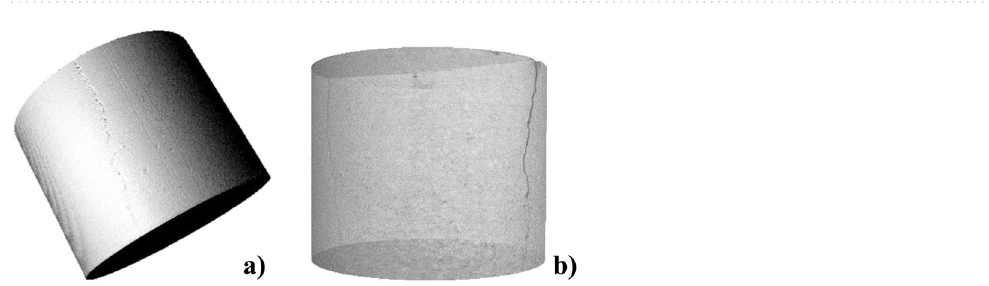
Figure 21. Analysis of pore orientation on the xy-axis ( a ) before degradation and ( b ) after degradation.